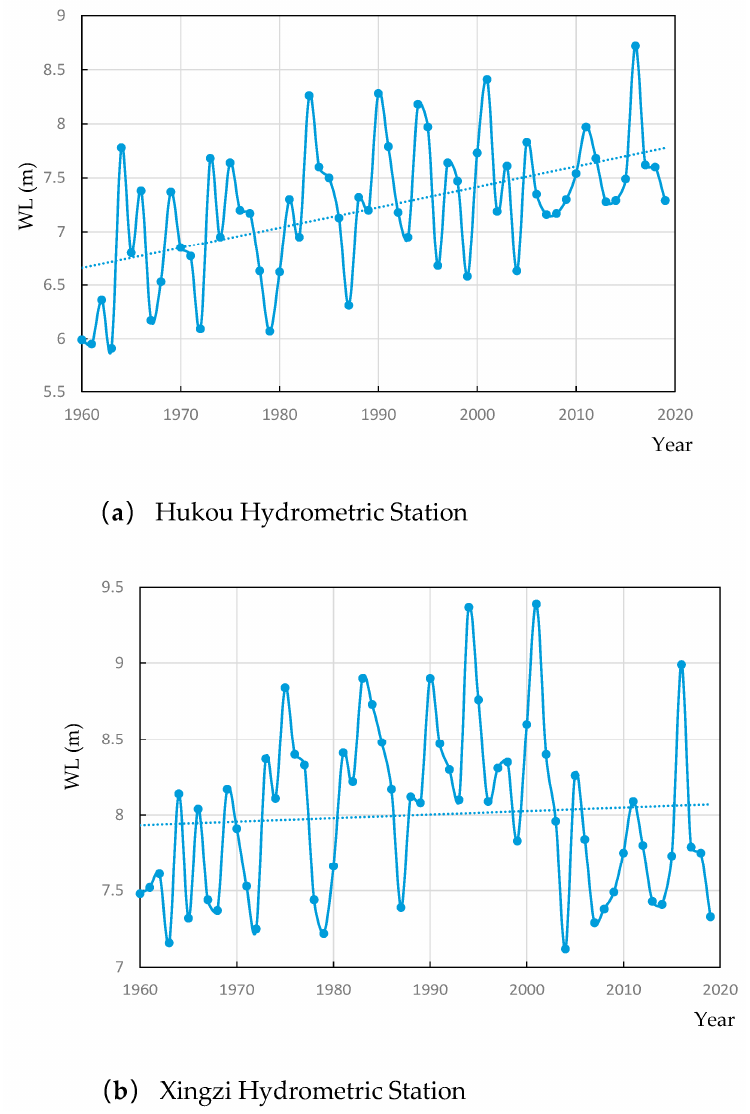
Figure 7. Annual lowest water level curve of each hydrometric station in the Poyang Lake area over the years.